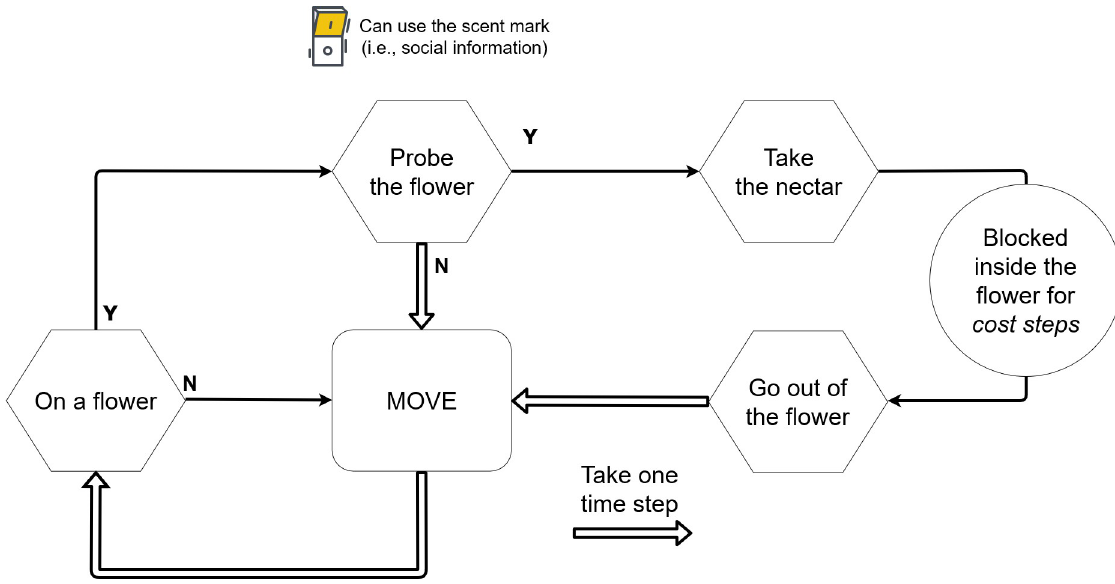
Fig 1. Scheduling of the pollinator.